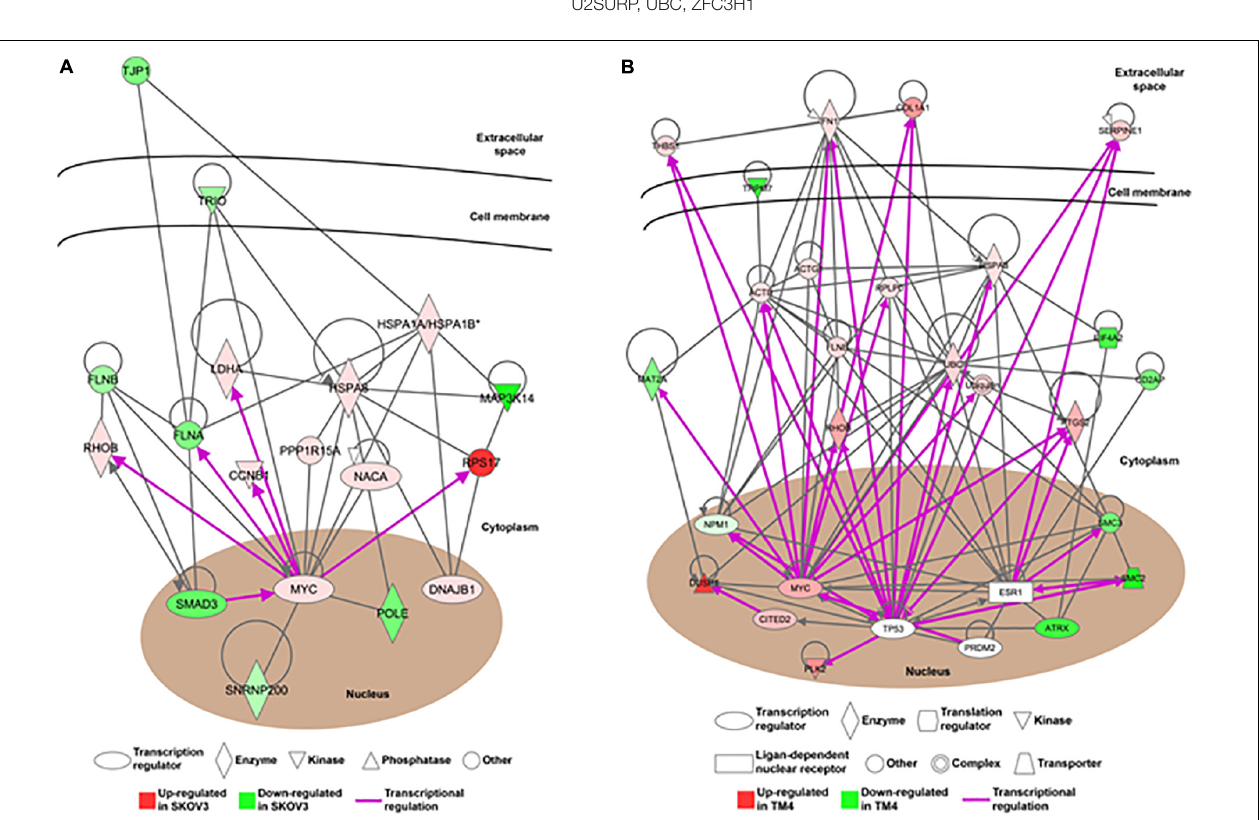
FIGURE 5 | The alteration of gene networks is caused by the ionizing radiation. The gene networking of the Ingenuity Pathway Analysis (IPA) showed the gene networks in response to the ionizing radiation in (A) female reproductive cells and (B) male reproductive cells. Red color represented upregulated genes and green color represented downregulated genes. The purple arrow showed the direct transcriptional